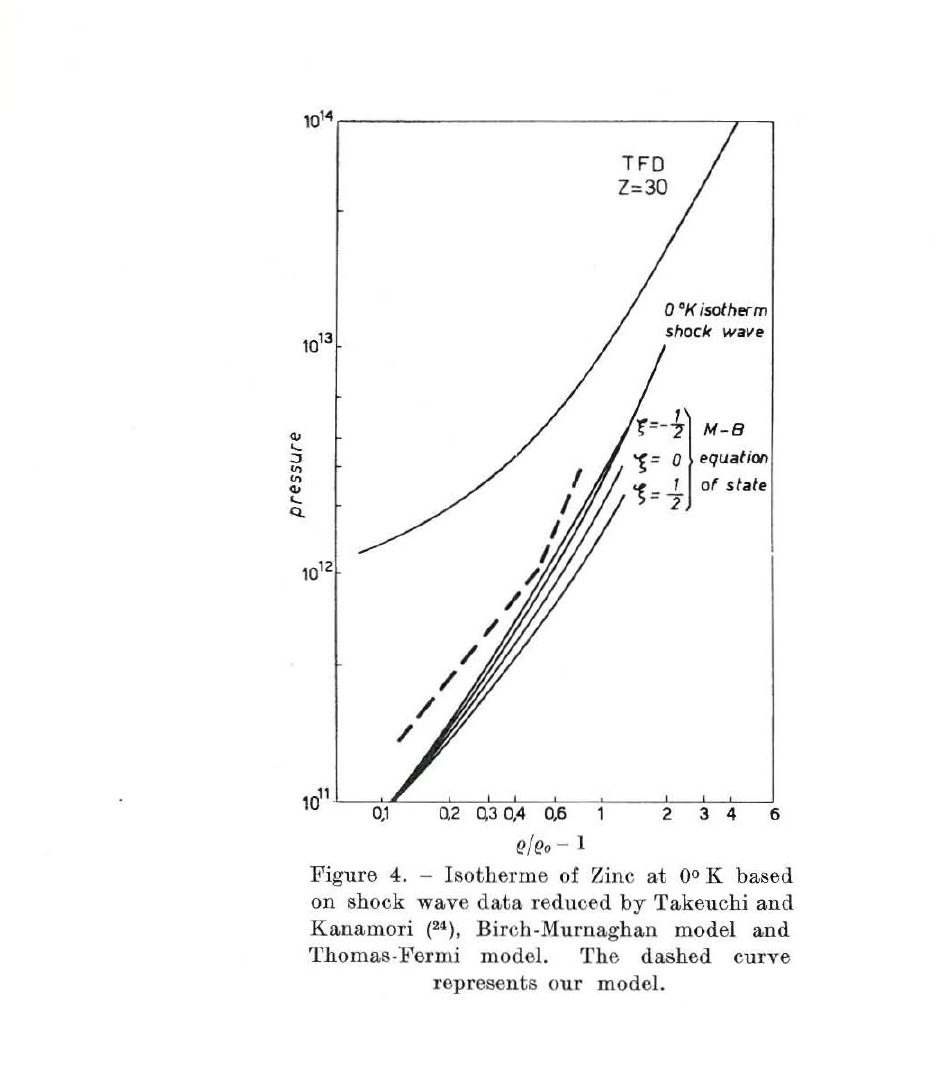
Figure 5. ~ Isotherme of Silver at 0° K basod on shock wave data reduced by Takeuchi and Kana.wori (U), Birch-Murnaghan model and Thomas-Fermi modeI. The dashed curve represents Qur